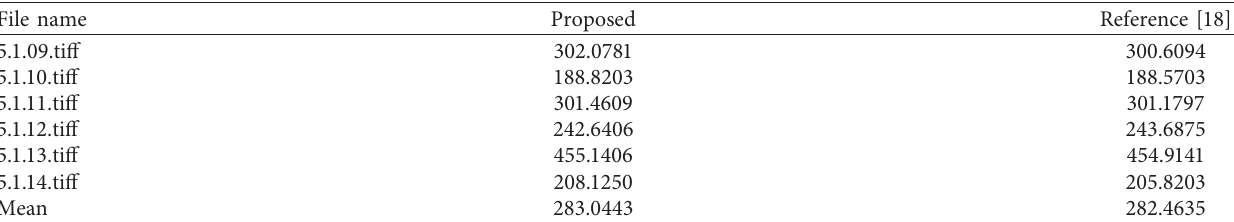
Table 14: Encryption quality analysis.